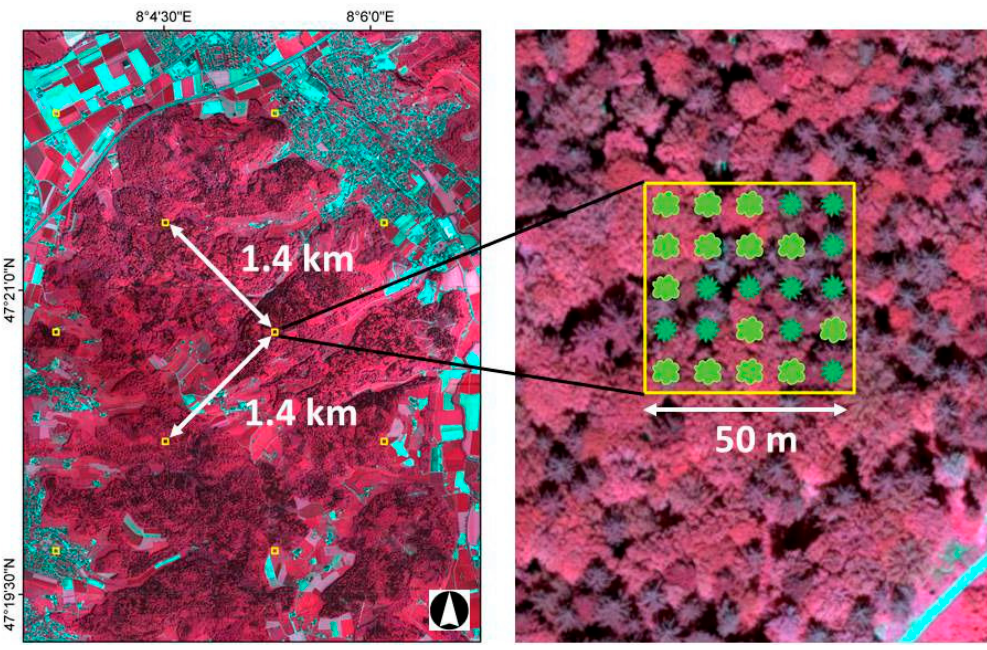
Figure 3. Interpretation of the 25 sub-sampling points ( Right ) of a 1.4 km regular raster; ( Left ) for coniferous (green) and broadleaved (light green) tree type decisions.